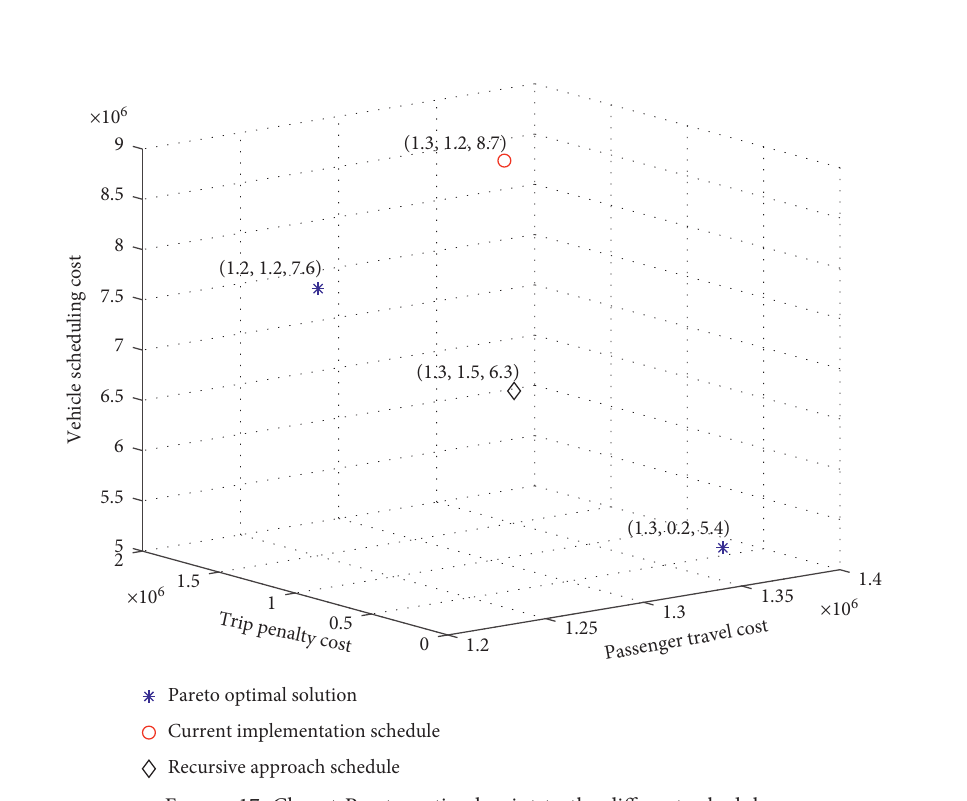
Figure 17: Closest Pareto optimal point to the different